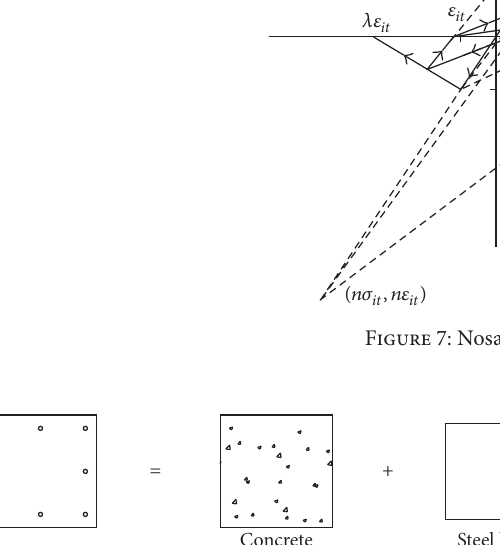
Figure 8: Reinforcement model for frame